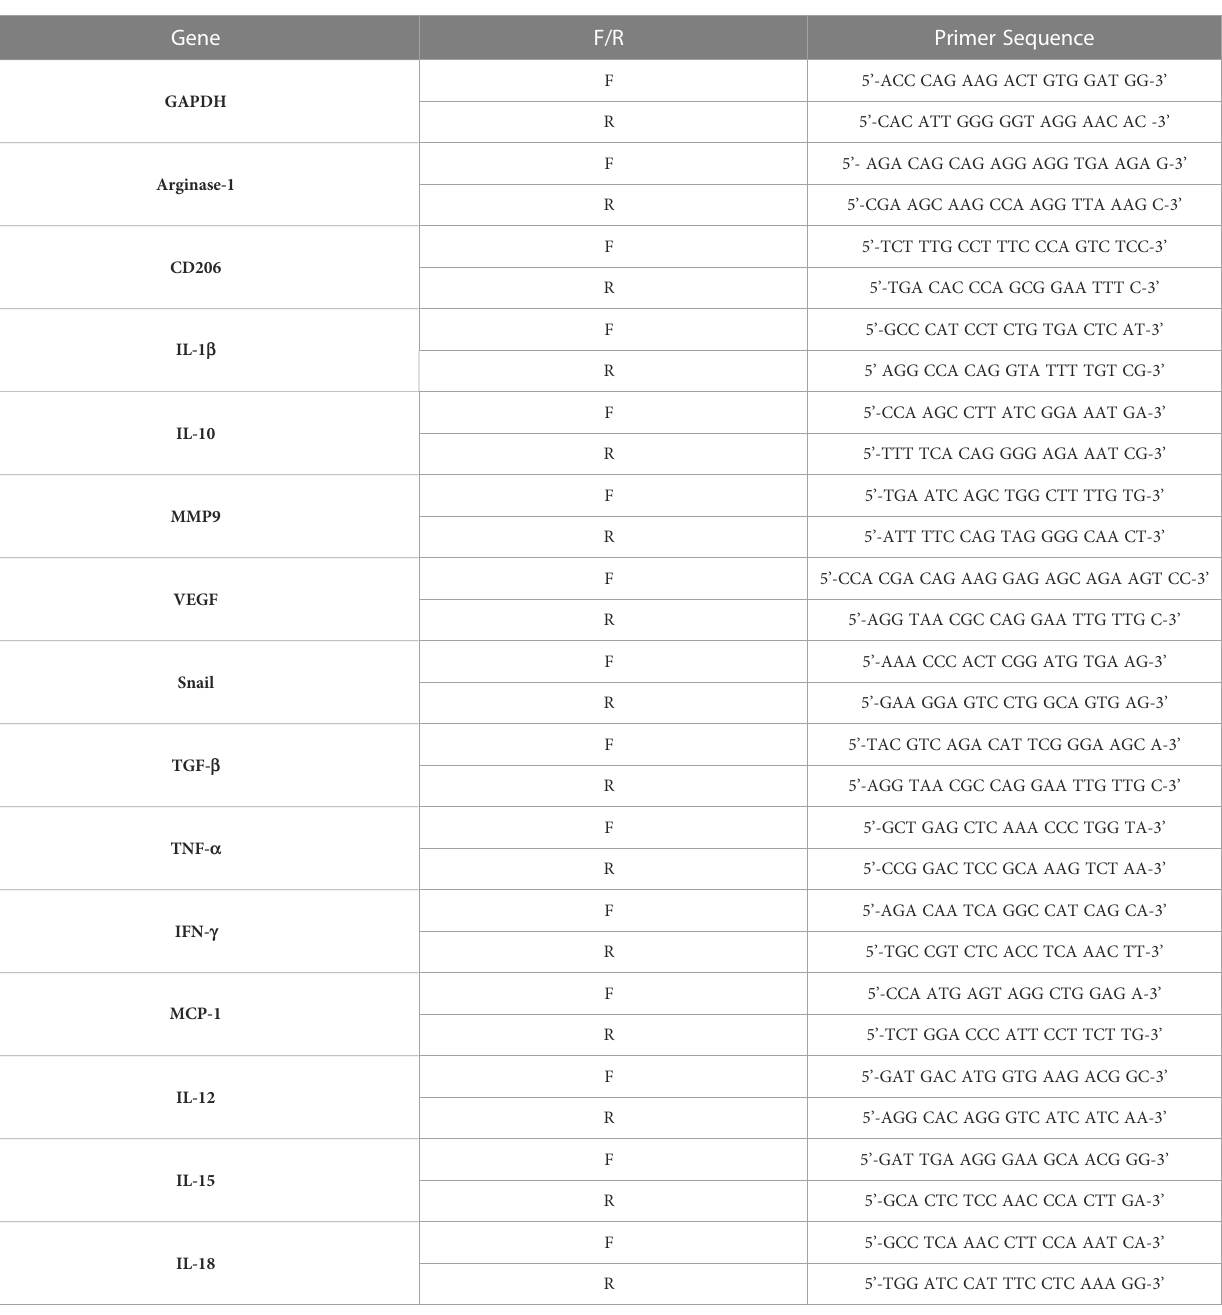
TABLE 1 Primers used in Real-Time